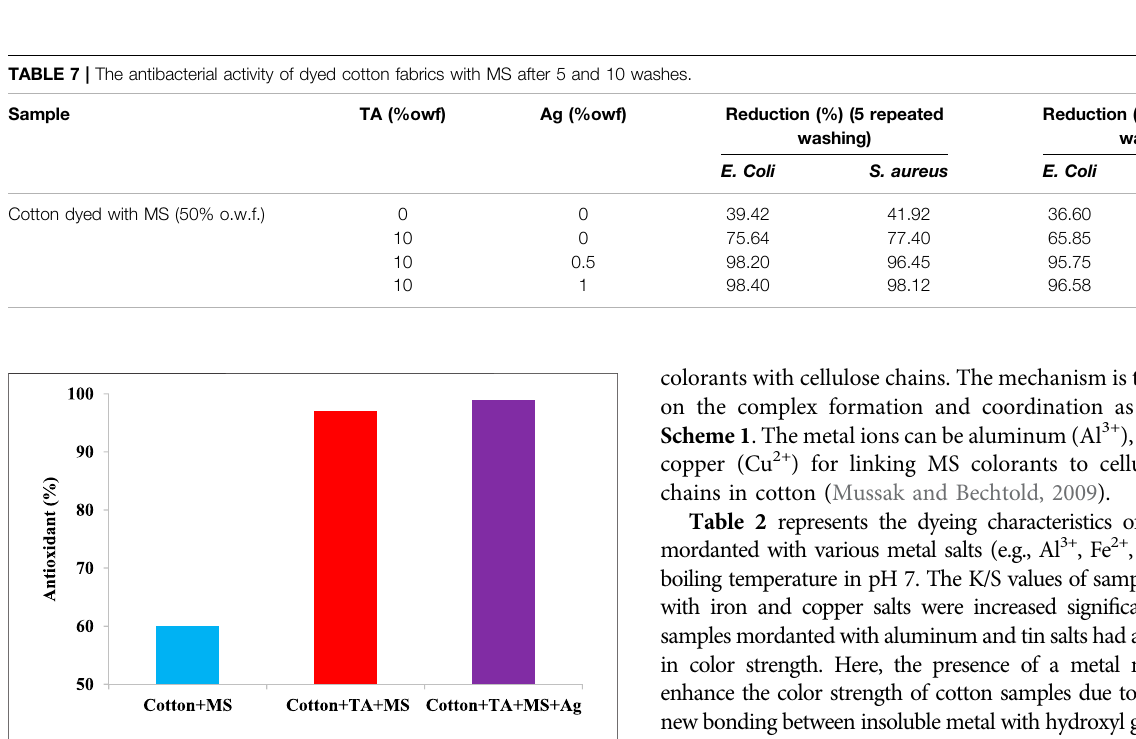
Frontiers in Bioengineering and Biotechnology |